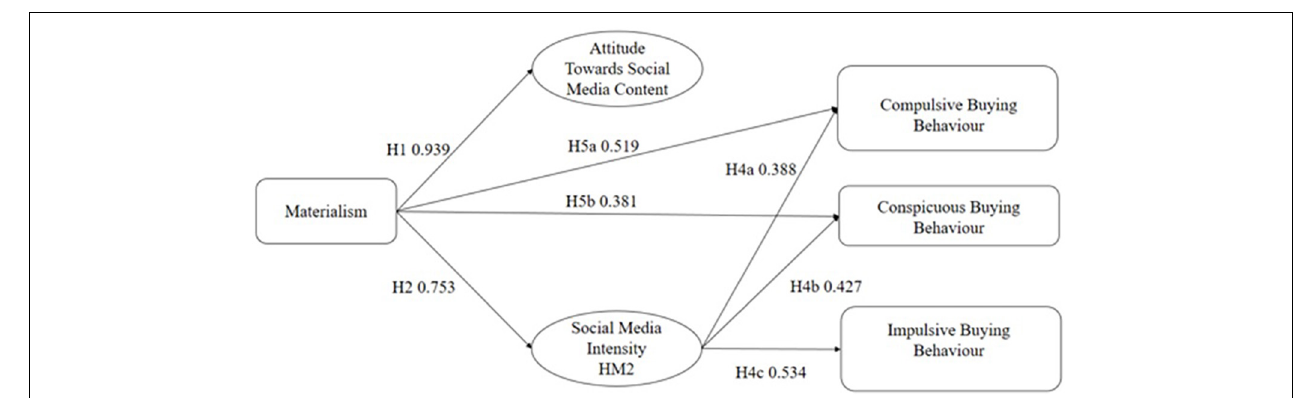
FIGURE 2 | Conceptual framework significant